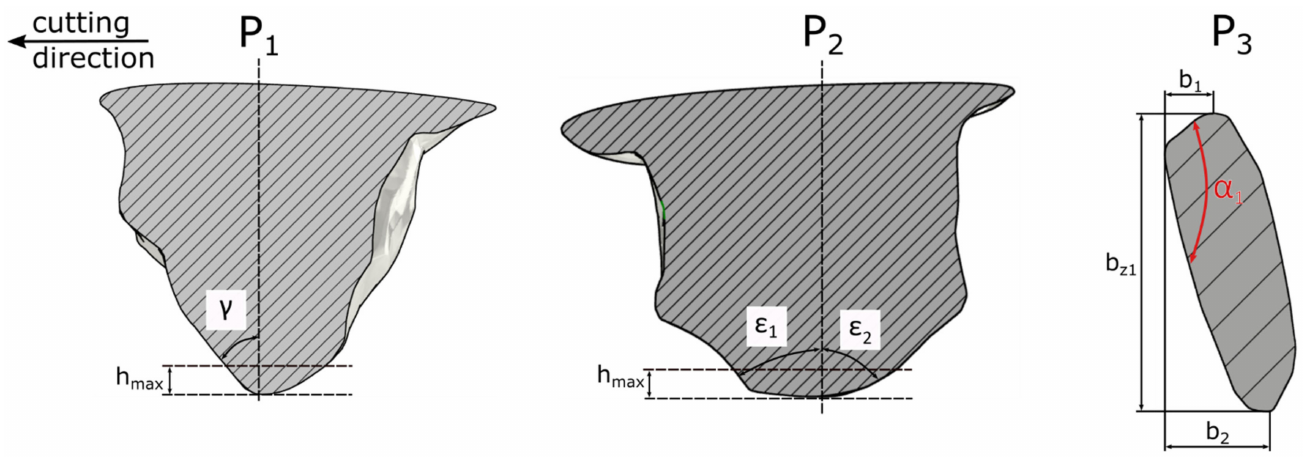
Figure 6. Geometrical properties of abrasive grain